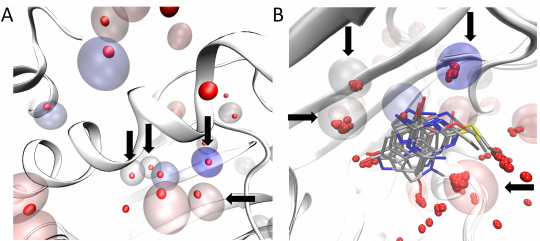
Figure 2. Identification of water molecules within the binding site of N-HSP90 (PDB ID: 5J2V). Panel ( A ): The red opaque spheres correspond to the oxygen atom of the crystallographic water with a low B-factor (below 25) while the transparent spheres are the cell predicted by AquaMMapS with a high %O RMSF value (above 25), the color of the AquaMMapS cell refers to the %O RMSF value of that cell (the %O RMSF value increases from red to blue). As it can be observed, there is a good agreement between the high occupancy AquaMMapS cells and the low B-factor crystallographic water molecules. Panel ( B ): Superposition of the 11 crystals structures used in this work. The Four highly conserved water molecules identified by pyWATER are marked by the black arrows. Each highly conserved water molecule corresponds to a high %O RMSF value AquaMMapS cell (the cells displayed have all an %O RMSF value greater than